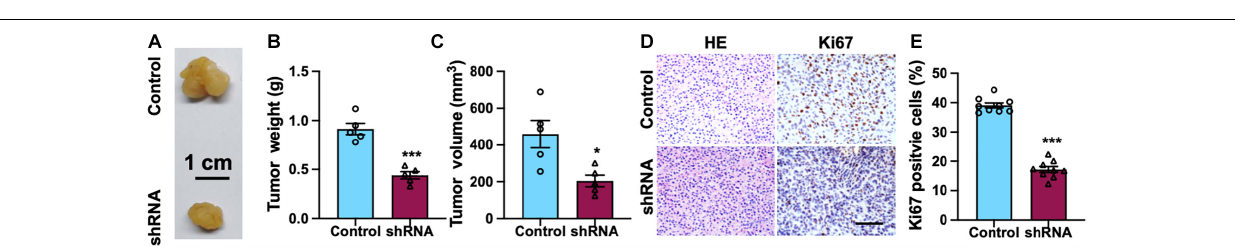
FIGURE 5 | Silencing of SH2B3 augments TMZ-induced suppression of mouse xenograft tumors growth. (A) Representative images of tumors derived from U87 control or shRNA cells. Scale bar = 1 cm. (B) Weight of indicated tumors. (C) The volume of indicated tumors. (D) Immunohistochemistry staining with tumors derived from U87 control or SH2B3 shRNA cells using Ki67 antibody and representative images were shown. Scale bar = 100 µ m. (E) Quantification data for panel (D) . Control or shRNA means indicated tumors derived from cells expressing control shRNA or SH2B3 shRNA, respectively. *, **, and *** indicate p < 0.05, p < 0.01, and p < 0.0001,